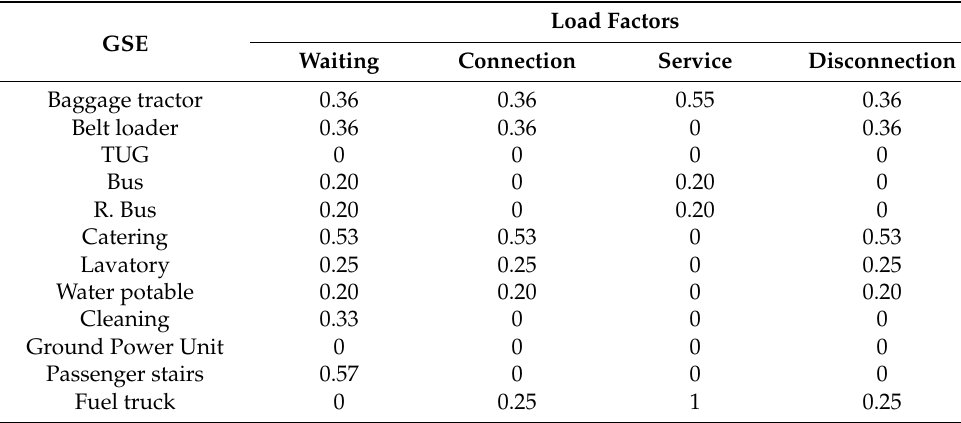
Table A3. Load factors according to unloading times and operation.